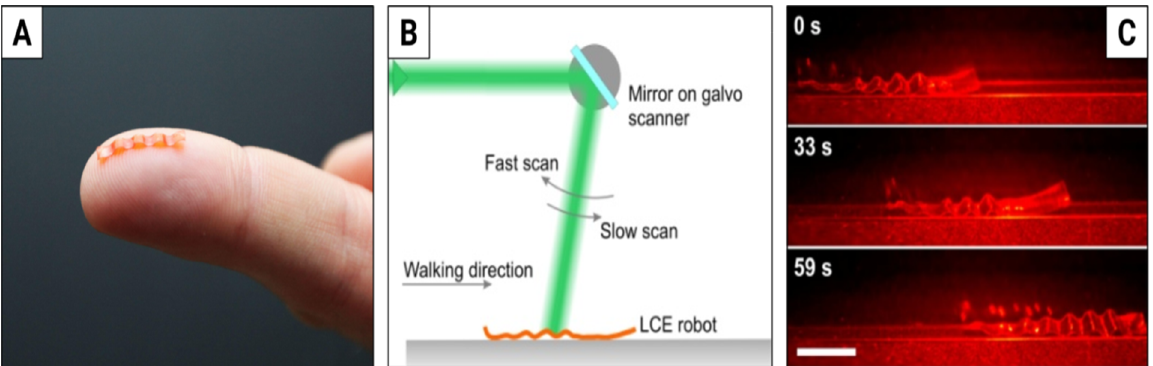
Figure 4. Natural scale crawling caterpillar robot. ( A ) The caterpillar robot on the fingertip of one of its creators. ( B ) Schematic of the experimental setup—the green laser beam is scanned along the robot’s body with a galvo mirror driven by an asymmetric sawtooth signal. The beam was scanned at 0.4 Hz and had 2.5 W of power. ( C ) Snapshots of the video with the light-driven caterpillar crawling on a level surface. The white scale is 5 mm long. The laser light is filtered out with an orange optical filter. Adapted from [50].